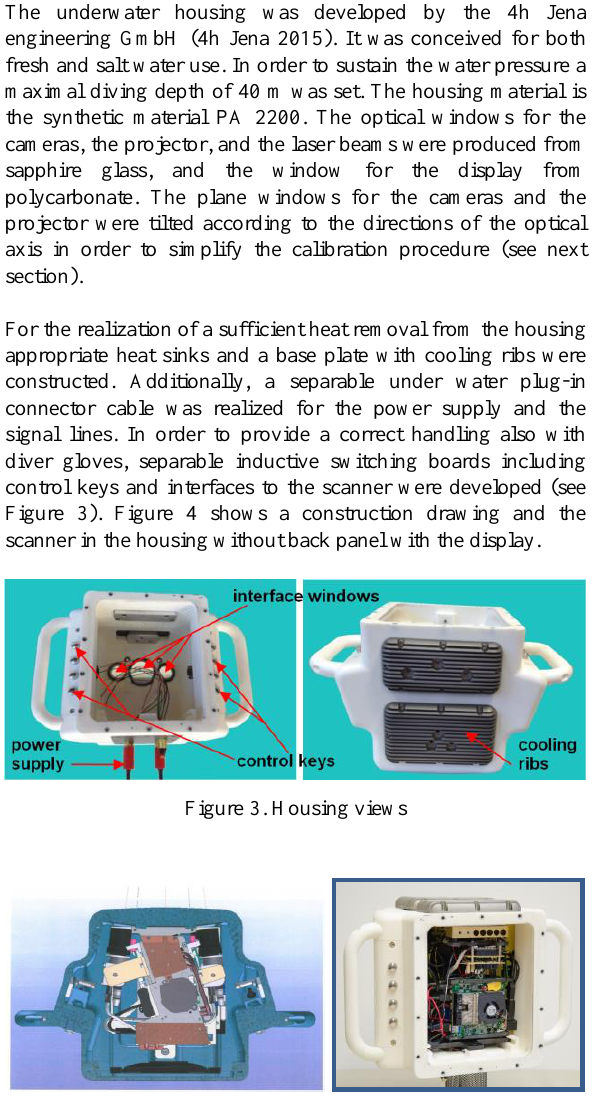
Figure 4. Housing views: construction draw, view from above (left), sensor inside housing without back-panel (right)